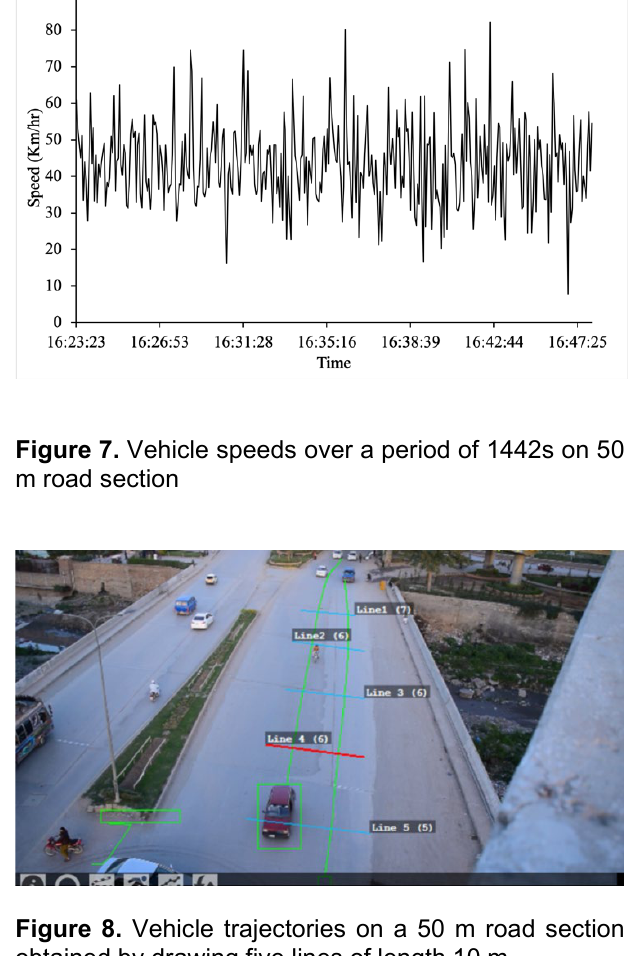
Figure 8. Vehicle trajectories on a 50 m road section obtained by drawing five lines of length 10